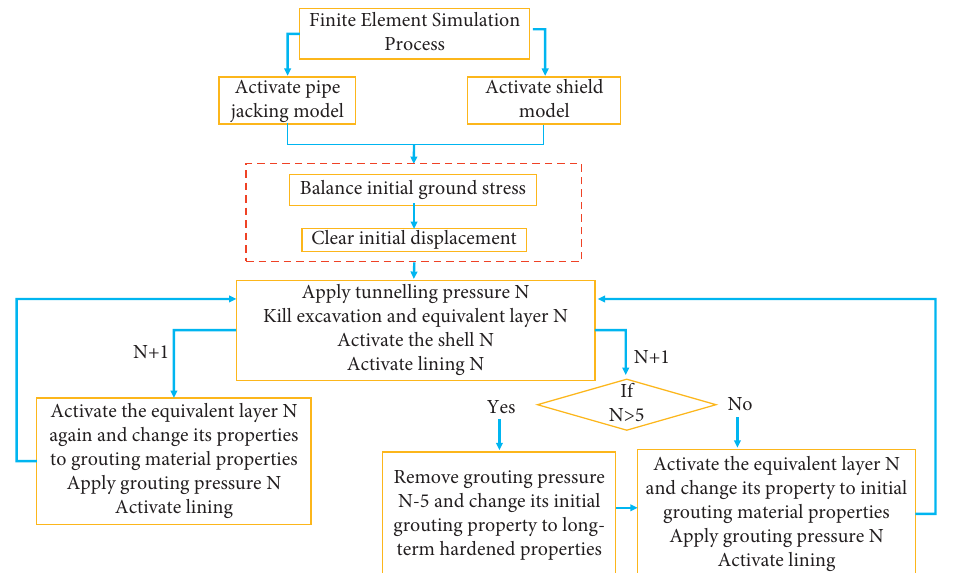
Figure 7: Simulation